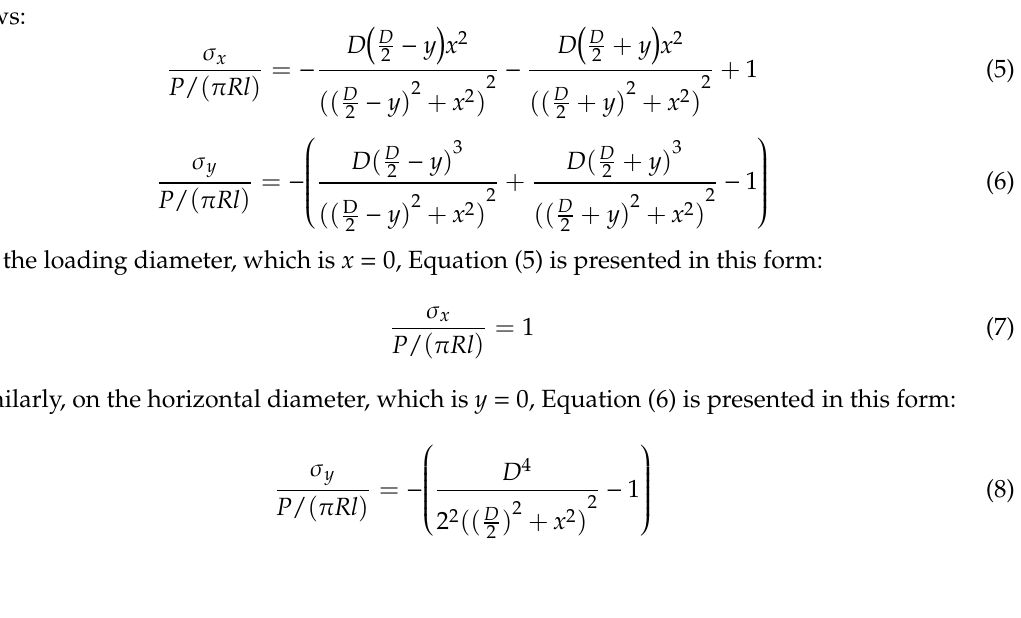
Figure 4. Indirect tensile